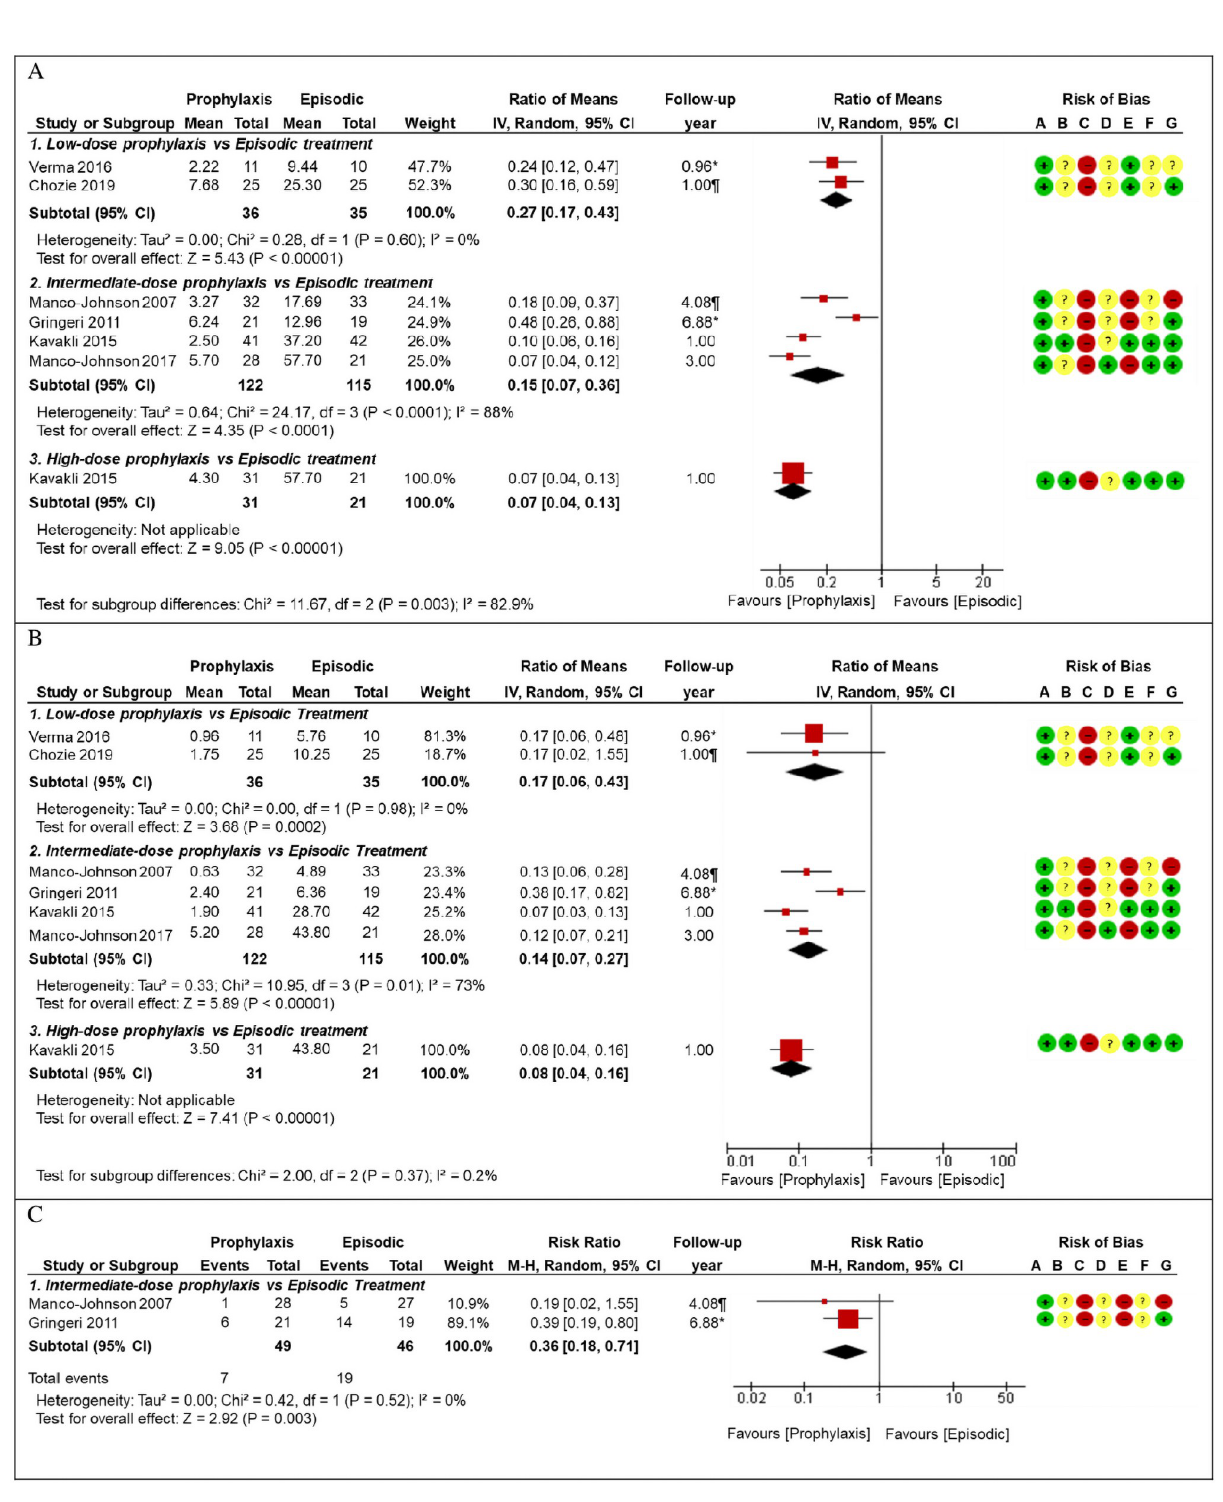
Fig 3. Forest plot for episodic versus prophylactic factor replacement therapies. � Mean, Median. (A) Forest plot for annualized bleeding rate, episodic treatment as control group. (B) Forest plot for annualized joint bleeding rate, episodic treatment as control group. (C) Forest plot for radiographic findings, episodic treatment as control